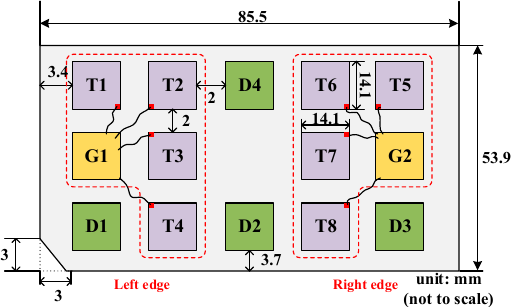
Figure 3. Geometries and layout of chips inside studied submodule of press-pack IGBT. There are eight IGBT chips (marked as T), four FWD chips (marked as D) and two gate pads (marked as G) placed on the collector pad of the press-pack submodule in total. The IGBT chips share the same size as the FWD chips. Meanwhile, the gate pad at the left or right edge is linked up to four IGBT chips through silver wire. Since the distance between IGBT chips at the same edge and the gate pad is almost the same, it can be assumed that all four of the IGBT chips in parallel switch simultaneously as one group. Thus, the current sharing among the paralleled chips is balanced and the electrical stress of each chip is supposed to be equal. Based on the structural information analyzed above, the cross-sectional view of the internal structure of the submodule for press-pack IGBT device can be sketched as in Figure 4 to illustrate the heat flux and distribution of the target IGBT module.